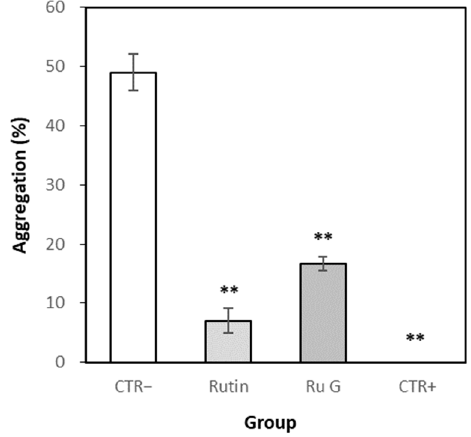
Figure 7. The aggregation rates of platelet-rich plasma (PRP ) in vitro. Each time point represented the mean ± S.E. ( n = 3). CTR − ; normal control (distilled water), CTR+; positive control (aspirin), Ru G; rutin glycoside. Significant differences from the normal control group were identified using In- dependent t -test (** p < 0.01).